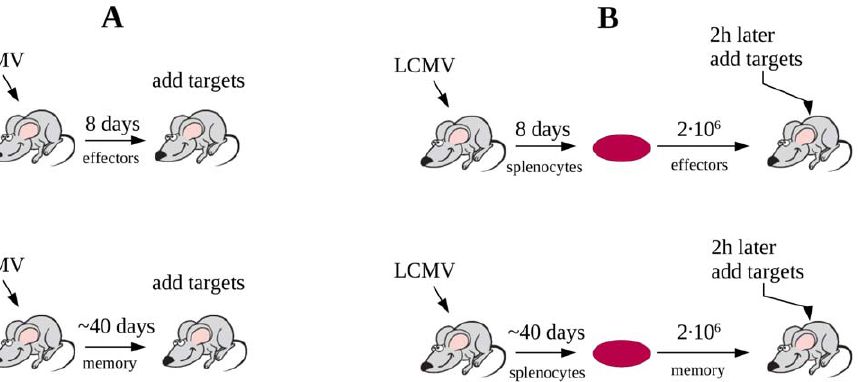
Figure 1. Schematic representation of the in vivo cytotoxicity assays undertaken to investigate the quantitative details of CD8 + T cell mediated killing of peptide-pulsed targets in the mouse spleen. In the first set of experiments (‘‘LCMV infection’’, panel A), B6 mice were infected with LCMV-Arm and 8 or 37–100 days later, three populations of 5 | 10 6 target cells (pulsed with either NP296 or GP276 peptides of LCMV and unpulsed) were transferred into these mice. In the second set of experiments (‘‘adoptive transfer’’, panel B), P14 TCR Tg CD8 z T cells, specific to the GP33 epitope of LCMV, were transferred into B6 mice and then infected with LCMV-Arm. Eight or 40 days later, different number of effector (day 8) or memory (day 40) P14 CD8 z T cells from these mice were transferred into new naive B6 mice (in panel B, we shown an example where 2 | 10 6 effectors or memory CD8 z T cells are transferred). Two hours later, two populations of 5 | 10 6 targets (pulsed with the GP33 peptide of LCMV and unpulsed) were transferred into these mice now harboring GP33-specific CD8 z T cells. In both sets of experiments, killing of peptide-pulsed targets was measured in spleens of mice at different times after cell transfer [16].